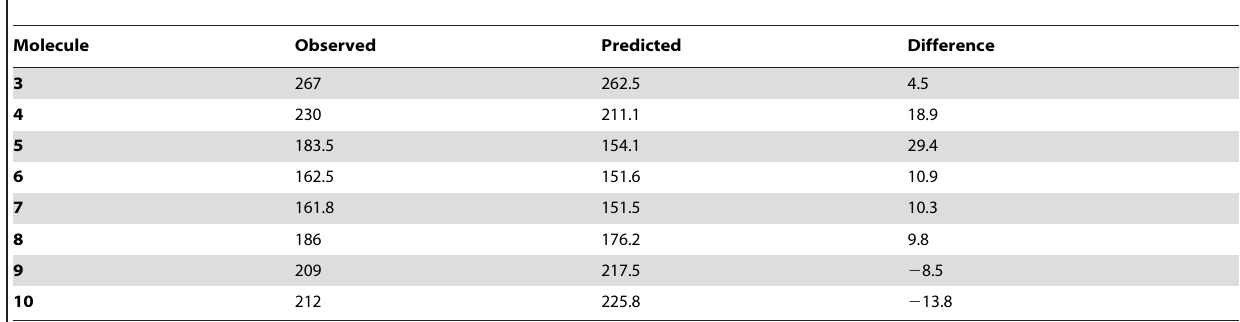
Table 3. Molecules containing sp or sp 2 atoms identified as outliers to the linear regression equations.